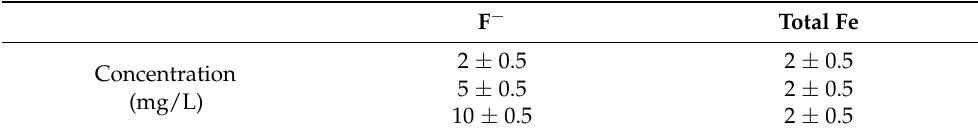
Table 3. Reference sample preparation.